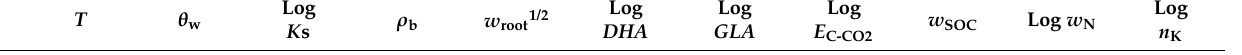
Table 2. Pearson’s product-moment correlation coefficients among the soil variables 1 along with an indication of their significance at the 95% (*), 99% (**), and 99.9% (***) confidence level.